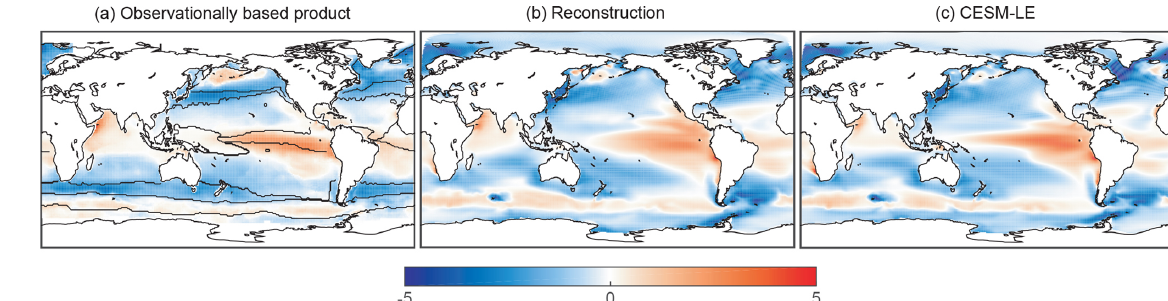
Figure 2. Annual mean air–sea CO 2 flux (molm − 2 yr − 1 ) over the period 1982–2015 as estimated by (a) the Landschützer et al. (2016) observationally based product, (b) the model reconstruction, and (c) the CESM-LE. Positive fluxes denote ocean outgassing, and black contours in (a) show biome boundaries.